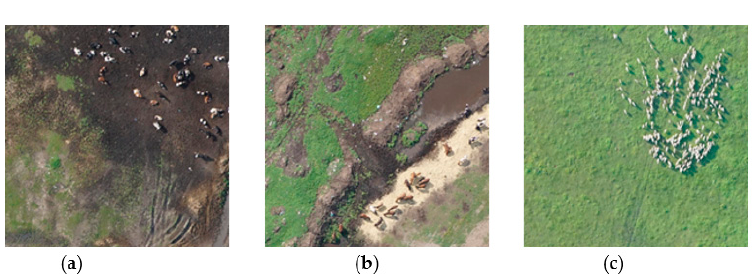
Figure 4. The object instances of the dataset. ( a ) ca tt le instances; ( b ) horse instances; ( c ) sheep in- stances. Table 2 and Figure 5 are the statistical information of the animal samples in the da- taset, as shown below. From Figure 5d, it can be seen that the side length of most object boxes is 10–20 pixels. The size of most sheep objects is in this range. The mean absolute size (MAS) is de fi ned as the square root of the object box average area, while the mean relative size (MRS) is de fi ned as the percentage of the mean area to the total patch area. The formula is as follows: (2) Table 2. Details of objects’ sizes in the dataset. Category Min Width Max Width Average Width